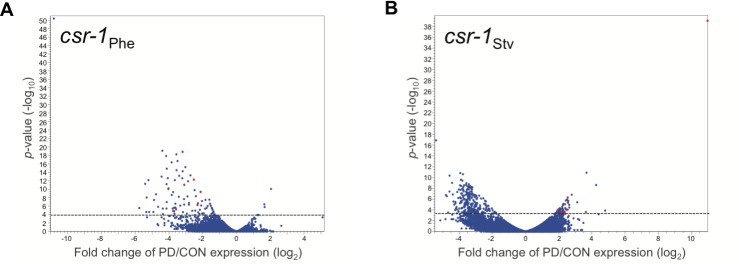
Environmentally programmed gene expression changes are dependent on CSR-1.(A, B) Volcano plots depicting csr-1Phe (PDPhe/CONPhe) and csr-1Stv (PDStv/CONStv) RNA-Seq data. Dotted line indicates FDR cutoff p = 0.05; dots above the lines are significantly different in PD compared to CON for a given condition. Red dots represent the csr-1Phe down::csr-1Stv up seesaw genes.